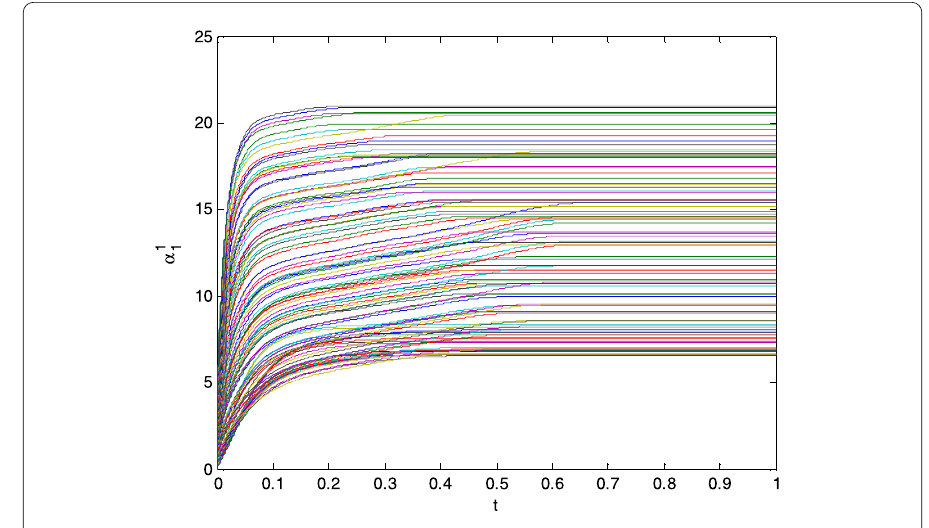
Figure 5 Trajectories of the adaptive law (12) about G 1